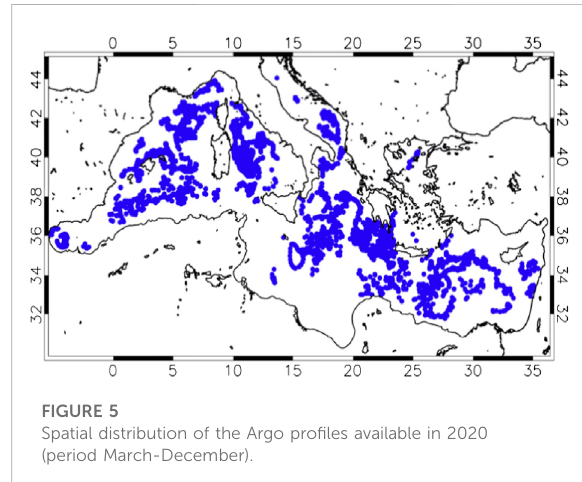
FIGURE 5 Spatial distribution of the Argo pro fi les available in 2020 (period